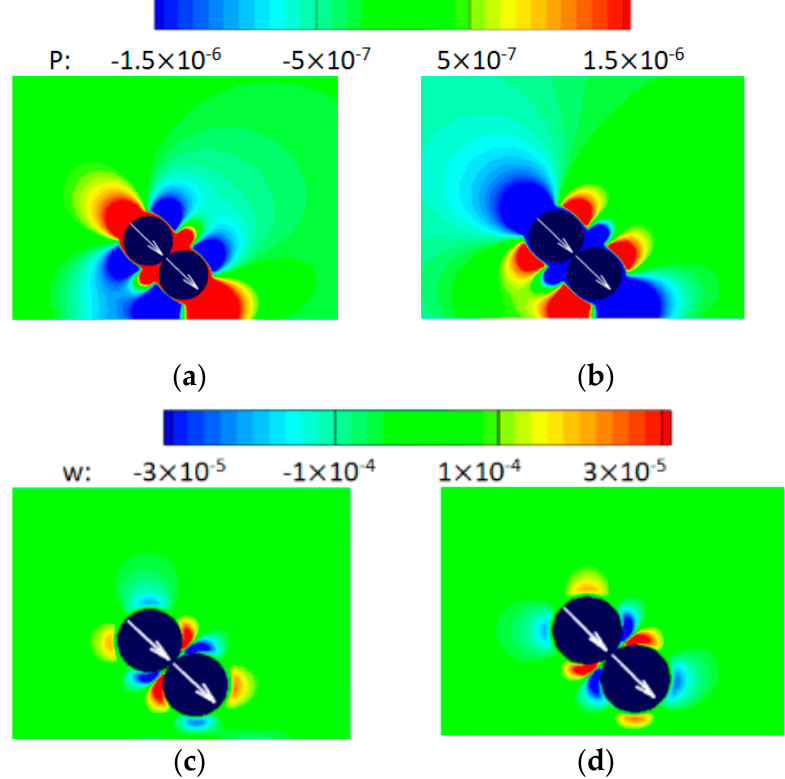
Figure 4. Pressure and vorticity distribution around a rod-shaped squirmer ( Re s = 0.1): ( a ) pressure, β = − 5; ( b ) pressure, β = 5; ( c ) vorticity, β = − 5; ( d ) vorticity, β = 5. Changes in the translational and angular velocity of rod-shaped squirmers with different values of β with time are compared in Figure 5. For the squirmer with − 9 ≤ β ≤ 1, the swimming velocity stabilized to a fixed value, which increased with an increase in the absolute value of β and was greater than the steady swimming velocity in the infinite flow. For the squirmer with 4 ≤ β ≤ 7, the swimming velocity always fluctuated within a certain range, which is consistent with the numerical results given by Li and Ardekani [16]. As shown in Figures 3b and 5b, within the period of time before the squirmer collided with the wall for the first time (i.e., the stage of tB 1 /2 d changing from 0 to 0.20 in the small diagram of Figure 3b), the azimuth angle of the squirmer with − 1 ≤ β ≤ 1 increased linearly, and the azimuth angle of the pusher ( β ≤ − 3) or puller ( β ≥ 4) increased or decreased first when swimming towards the wall; the rotational angular velocity of the puller was also greater than that of the pusher. The direction of the angular velocity of the squirmer was reversed when the squirmer was about to contact the wall, the azimuth angle of the pusher or puller began to suddenly decrease or increase, and its rate of change increased with the increase in the absolute value of β . Brown et al. [34] and Ouyang et al. [19] indicated that the hydrodynamic effect and degree of collision between squirmer and the wall were different with different values of β , so the magnitude of the change in the squirmer’s azimuth before and after collision was different. The degree of attitude transition of the squirmers with different values of β at the wall determines its swimming